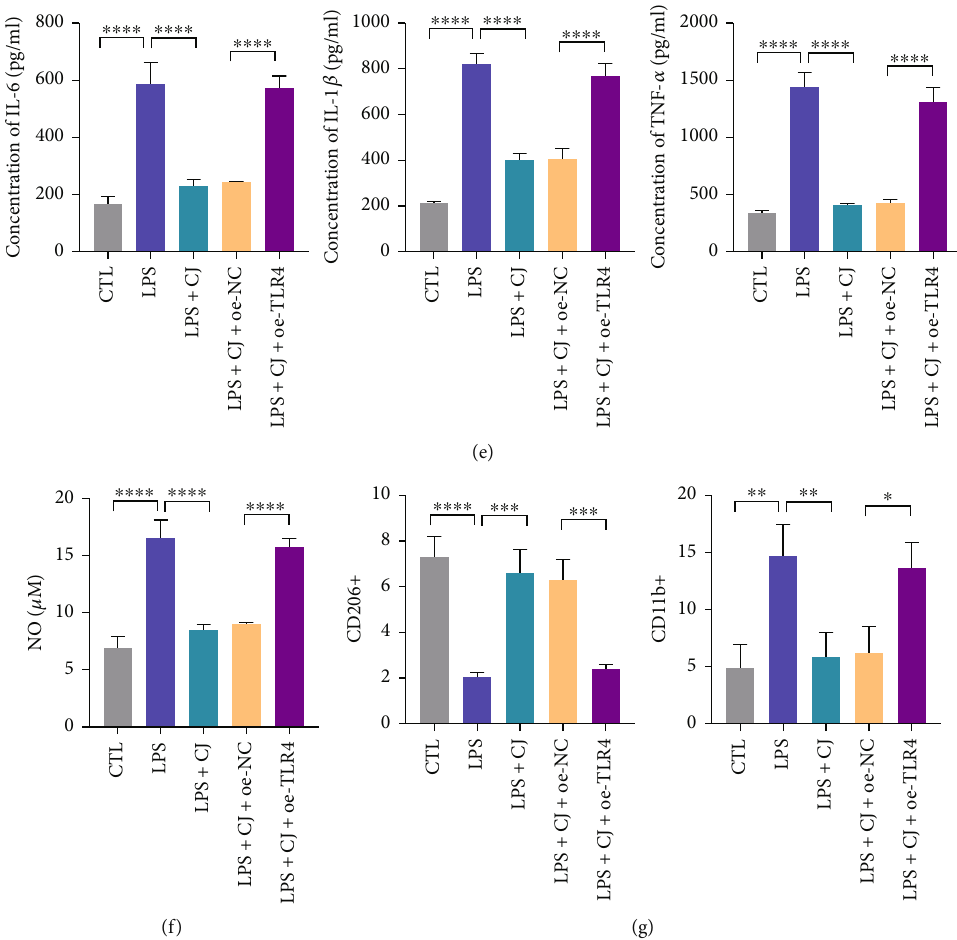
Figure 5: CJ a ff ects macrophage polarization and immune activity via the TLR4/MAPK/NF- κ B pathway. (a) mRNA levels of TLR4 measured by RT-qPCR. LPS (1 μ g/mL); CJ (200 μ g/mL). (b) TLR4 protein expression in macrophages by ELISA. (c) Total and phosphorylated protein levels of p38, ERK, JNK, and NF- κ B p65 in macrophages detected by ELISA. (d) The protein expression of CD206 and CD11b in macrophages measured by Western blot assay. (e) IL-6, IL-1 β , and TNF- α levels in macrophages detected by ELISA. (f) Intracellular NO concentration determined by the Griess reagent. (g) Determination of CD11b + (M1 type macrophages) and CD206 + (M2 type macrophages) signals in RAW264.7 cells. ∗ p < 0 : 05 ; ∗∗ p < 0 : 01 ; ∗∗∗ p < 0 : 001 ; ∗∗∗∗ p < 0 : 0001 . Cell experiments were repeated three